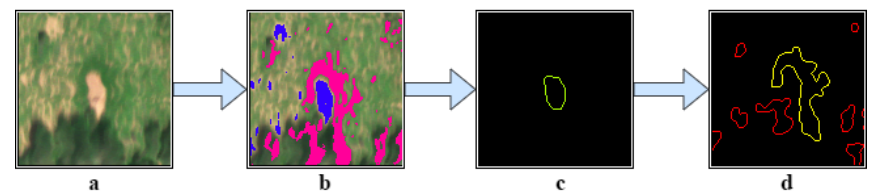
Figure 11. Contour analysis. ( a ) Cropped region. ( b ) classified material layers. ( c ) Detected contour at the soil layer. ( d ) Detected contours at the grass layer. Yellow contour: closest region from the contour ( c